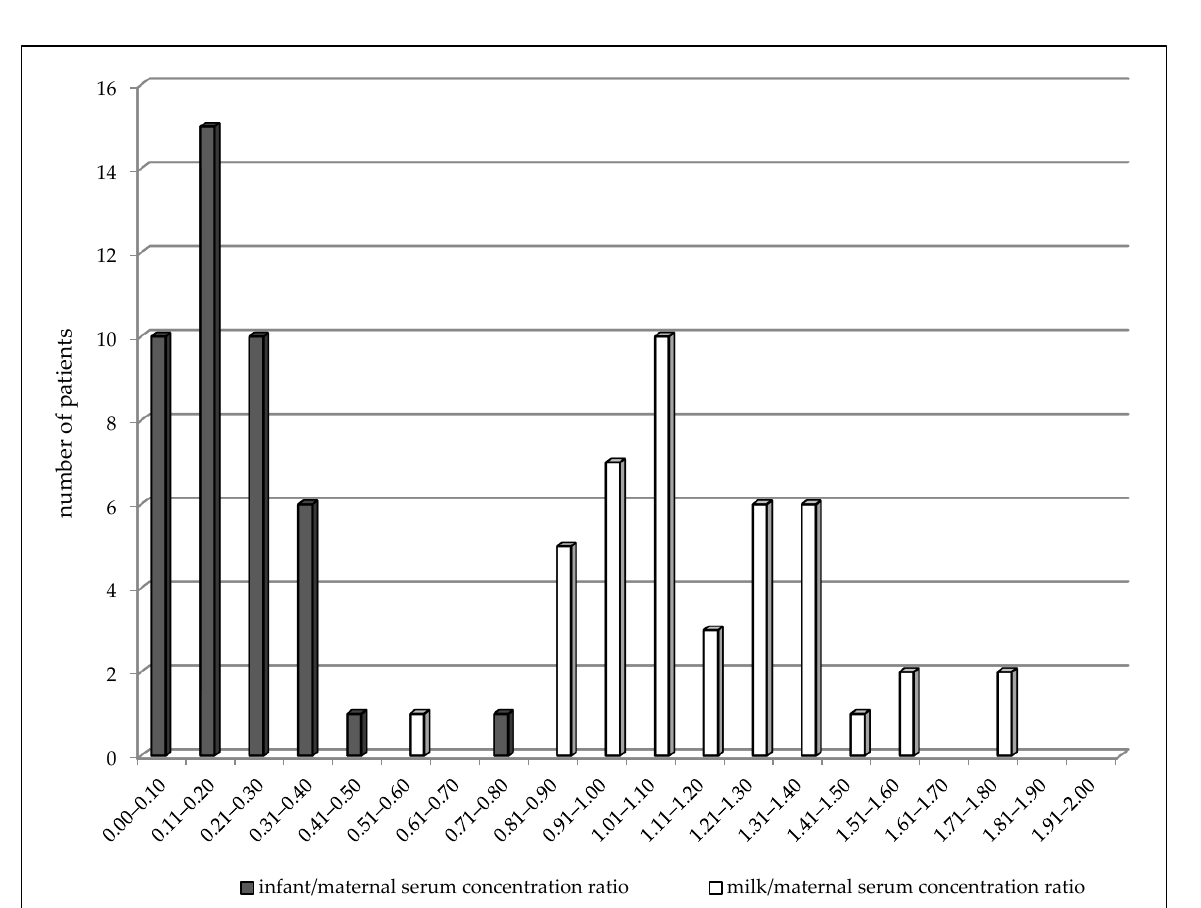
Figure 2. Comparison of distribution of paired milk/maternal serum concentration ratio (median = 1.07) and infant/maternal serum concentration ratio (median = 0.16) of levetiracetam 2–4 days after delivery. Number = 43, p < 0.0001 (Wilcoxon signed rank test).